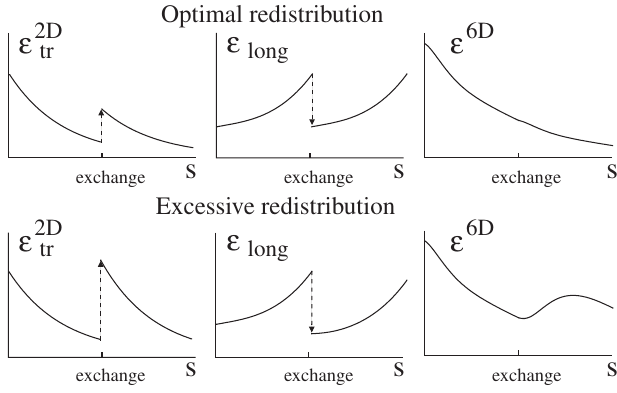
FIG. 7. Stylistic impression of the behavior of 2D transverse (involved into the redistribution process), longitudinal, and 6D emittances as functions of the length passed in matter during cooling. Top and bottom rows of figures correspond to the optimal redistribution from the longitudinal to transverse degree of freedom and excessive redistribution with undesirable full emittance increment, respectively. The redistribution is shown as a thin ideal process by dashed arrow. corresponds to the area of initial parameters where the antidamping dominates over diffusion. The ‘‘0’’ emittance case refers to a simulation where transverse motion was completely removed and, therefore, the obtained region is very close to that predicted by the linear model. One can therefore conclude that, while transverse motion is rela- tively independent of longitudinal parameters, longitudinal motion is strongly influenced by transverse beam parameters.